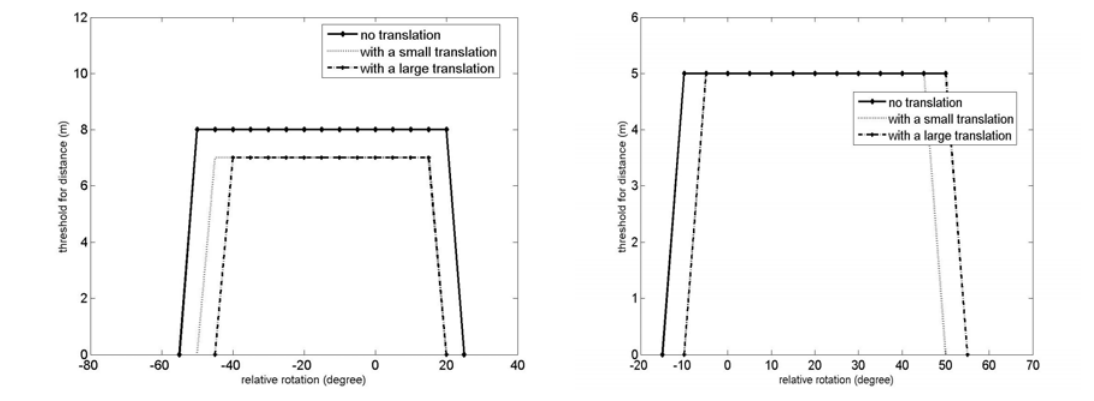
Figure 14. Initial threshold for distance, GP-ICP with the Agia Sanmarina church data. A large and small translations are [dx, dy, dz] = [0.5 m, 0.5 m, 1.0 m] and [0.1 m, 0.1 m, 0.1 m], respectively. The northeast of